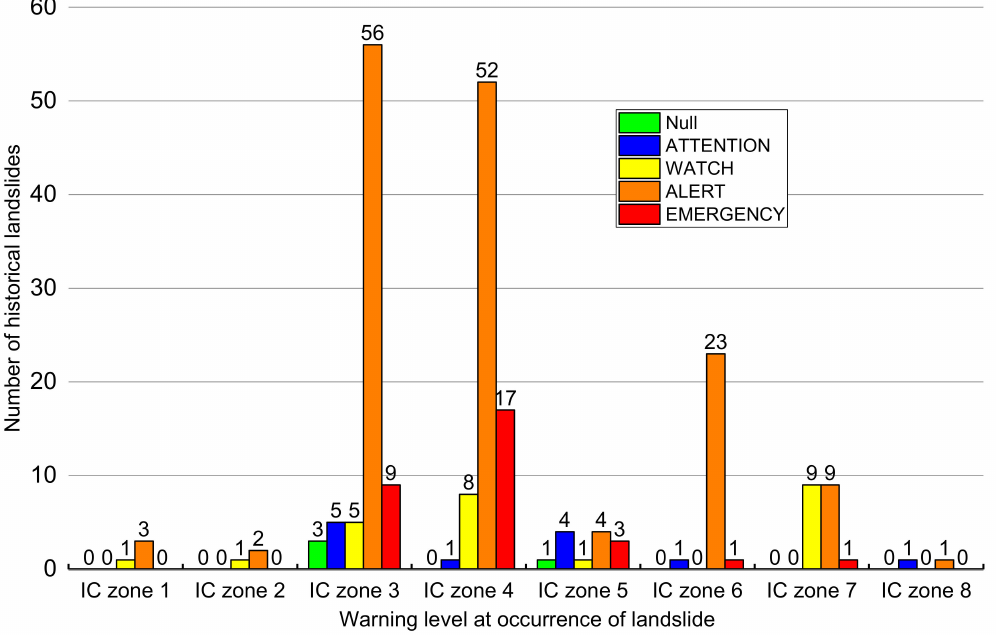
Figure 11. Prediction results of historical landslide data in each of the eight infiltration characteristic (IC) zones in